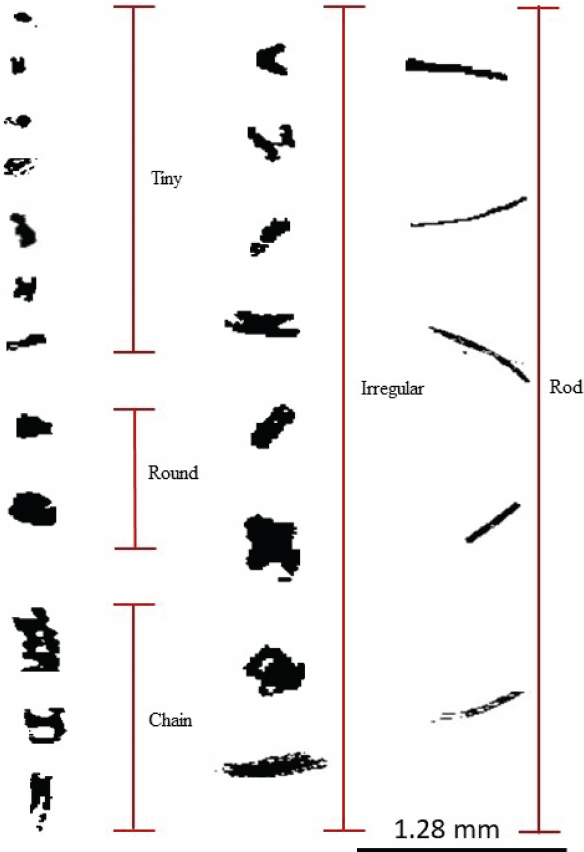
Figure 10. SAPs recorded within the BB plume by the 2D-S probe during the ORACLES 2018 campaign. SAPs were observed to be a variety of size and shapes, ranging from 10–1000µm in length. The figure shows the five primary shapes of SAPs observed during 2–3 October